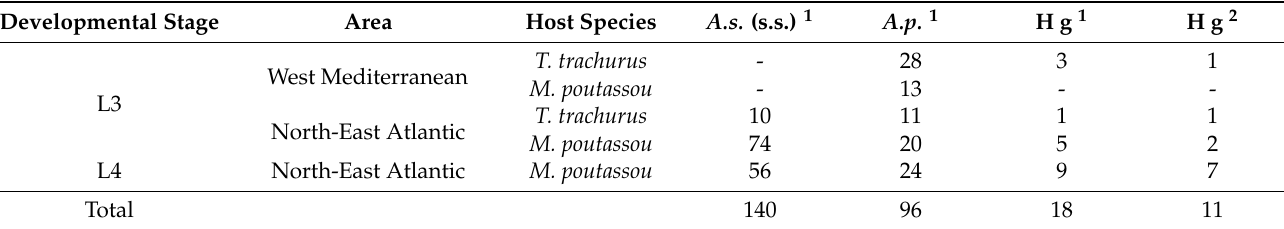
Table 1. Distribution and molecular identification of A. simplex (s.l.) L3 and L4 larvae. Developmental